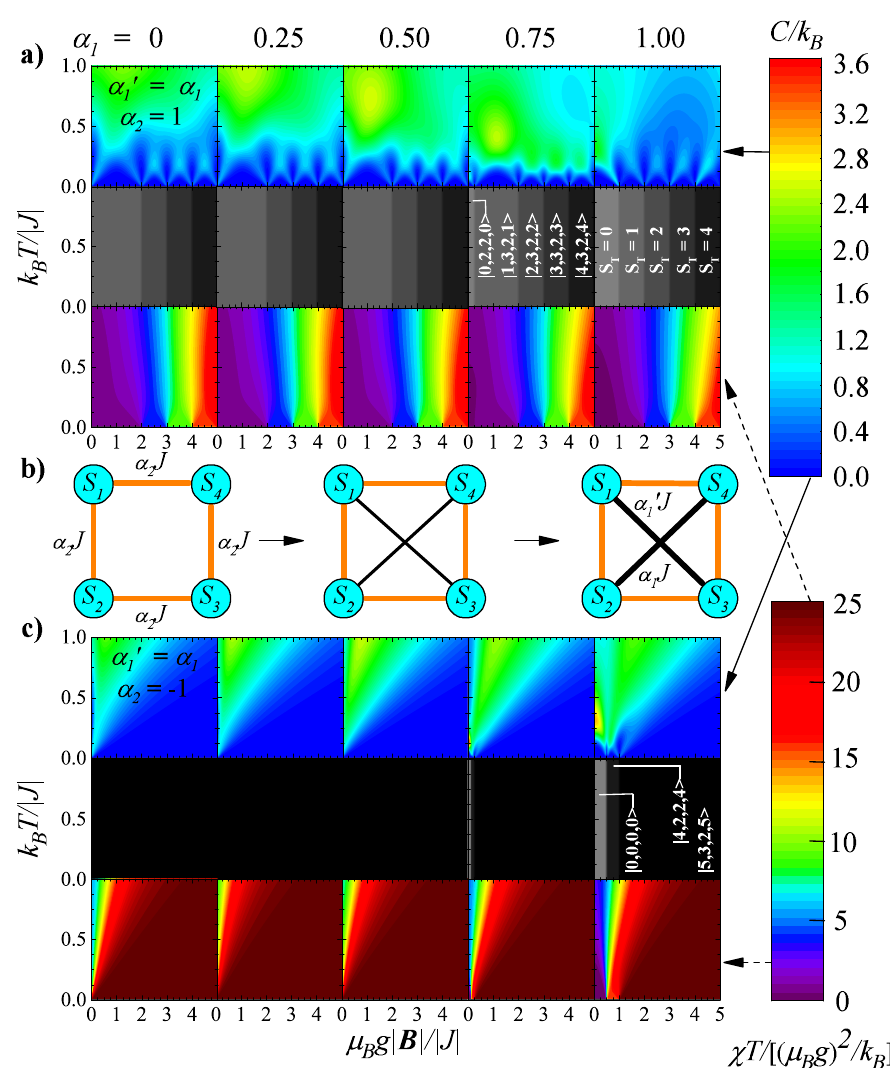
Figure 6. The figure compares the heat capacity , ground-state energy levels, and magnetic suscepti- bility times temperature as functions of k B T / | J | and µ B g | B | / | J | for the mixed valence ( S 1 = 3/2 and S 2 = 1) system. ( a ) The data for C (top), ground-state energy (GSE) (middle), and χ ∗ T (bottom) for = α = 1. ( b ) The evolution of the system evolving from the the case of α (cid:48) 1 , which varied while α 2 1 = α square configuration to the coupled tetramer configuration as α (cid:48) 1 varied from 0 to 1. ( c ) The 1 = α data for C (top), GSE (middle), and χ ∗ T (bottom) for the case of α (cid:48) 1 , which was varied while 1 α 2 = − 1. The ground states between the transitions are labelled throughout the diagrams. The first four panels (from left to right) contain the individually labelled states for those four panels. The last panel changes depending on the